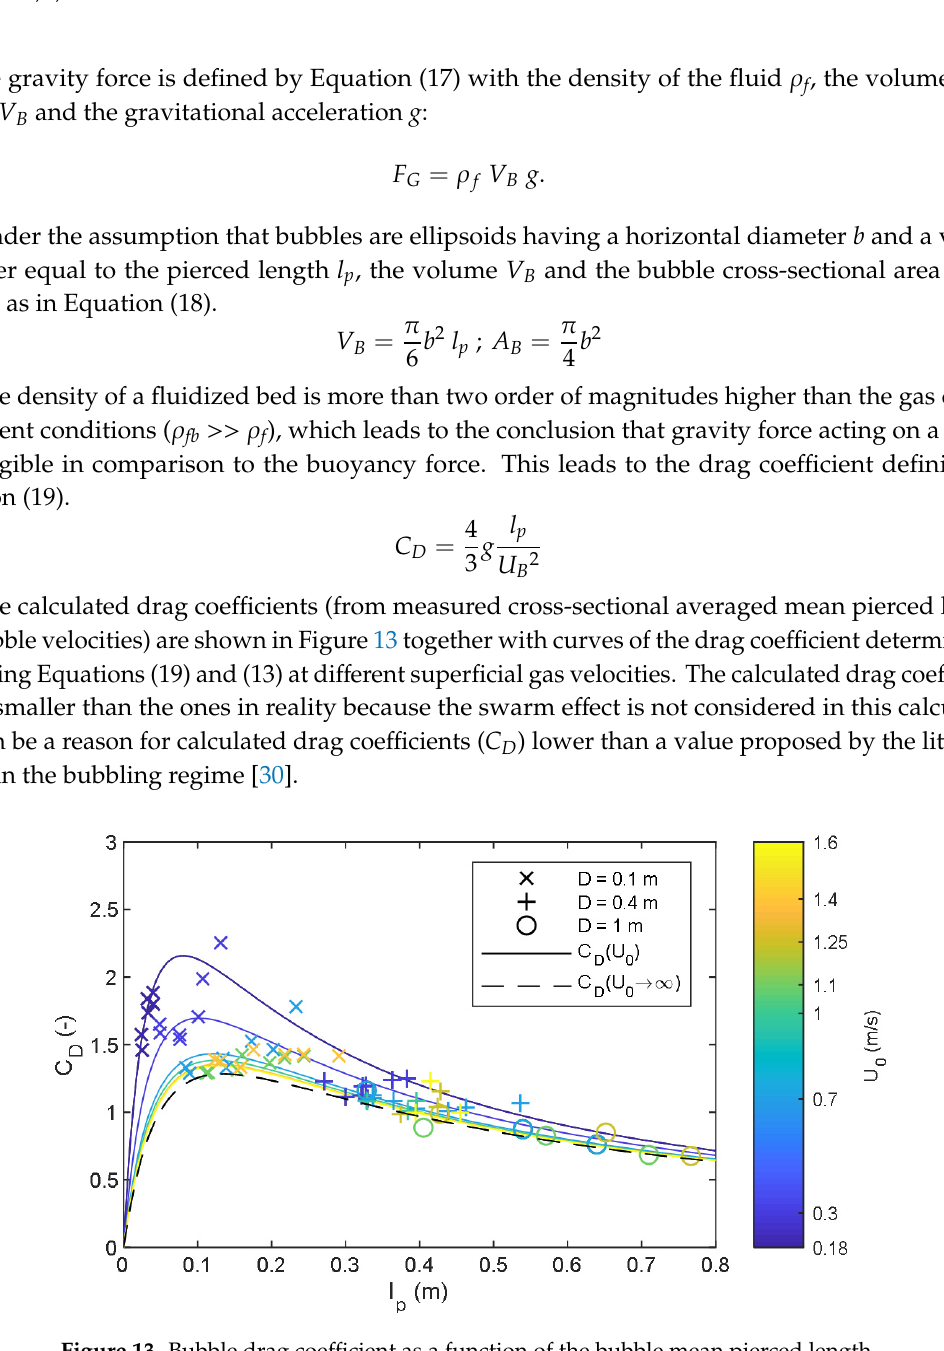
Figure 13. Bubble drag coefficient as a function of the bubble mean pierced length.